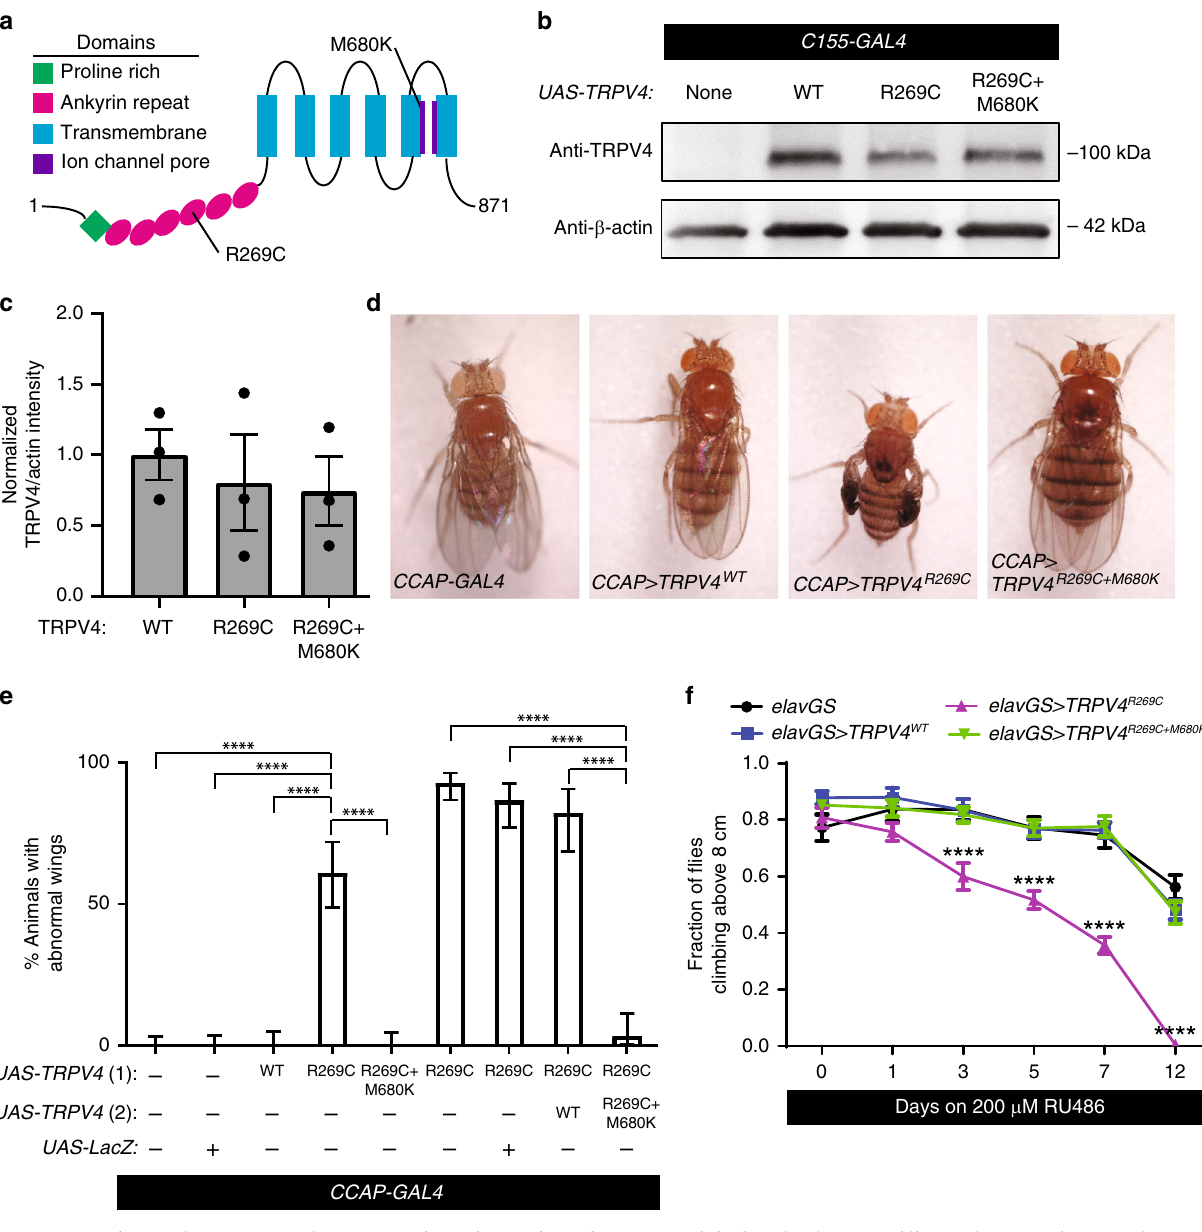
Fig. 1 A neuropathy-causing TRPV4 variant causes channel pore-dependent neuronal dysfunction in Drosophila . a Schematic of TRPV4 domain structure with neuropathy-causing (R269C) and pore-inactivating (M680K) mutations indicated. b Representative western blot of protein lysates from the heads of adult Drosophila expressing TRPV4(mod) variants under the control of C155 - GAL4 . c Normalized mean ± SEM band intensities from three independent western blots. One-way ANOVA ( p = 0.778). d Images of fl ies expressing no TRPV4, TRPV4 WT (mod), TRPV4 R269C (mod), and TRPV4 R269C + M680K (mod) in N fl ies with unexpanded wings in d . From left to right n = 115, 102, 73, 64, 82, 114, 75, 45, and 61 fl ies. Χ 2 of CCAP . e Percentage ± 95% CI of all groups ( p < 0.0001) followed by pairwise two-sided Fisher ’ s exact test. f Climbing performance of fl ies inducibly expressing TRPV4 (high) variants. Flies induced at 1 – 3 days post eclosion with 200 μ M RU486. Mean ± SEM. n = 10 vials of 10 fl ies per genotype. Two-way ANOVA ( p < 0.0001), Tukey ’ s post hoc test, asterisks indicate difference from all other genotypes. For all panels: **** p <